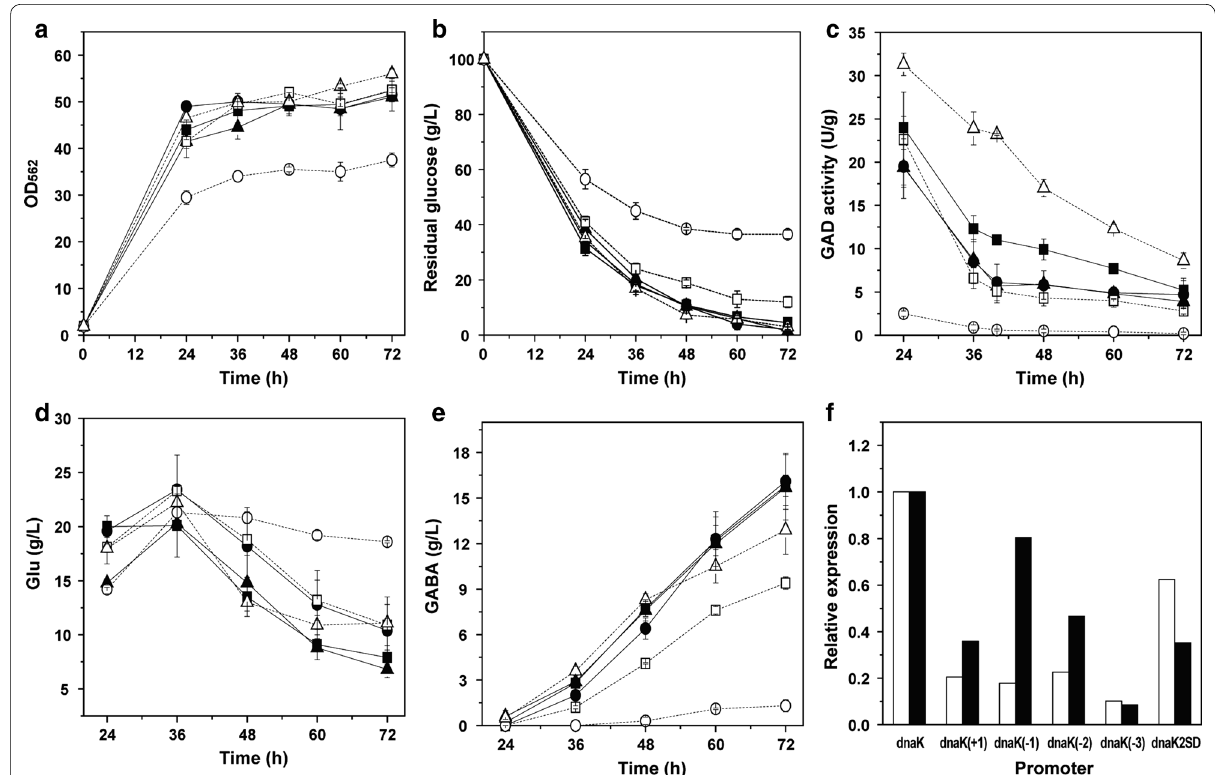
Fig. 6 GABA fermentation of gadB2 -expressing C. glutamicum strains under P dnaK promoter with different length and bicistronic architecture. a Cell growth, b glucose consumption, c GAD activity, d Glu production, e GABA production, f gadB2 transcription level. Squares P dnaK -B2, circles P dnaK ( 1)-B2, triangles P dnaK ( 1)-B2, empty squares in dotted line P dnaK ( 2)-B2, empty circles in dotted line P dnaK ( 3)-B2, empty triangles in + − − − dotted line P dnaK 2SD-B2. White bars at 20 h, black bars at 40 h. Averages of three independent experiments are